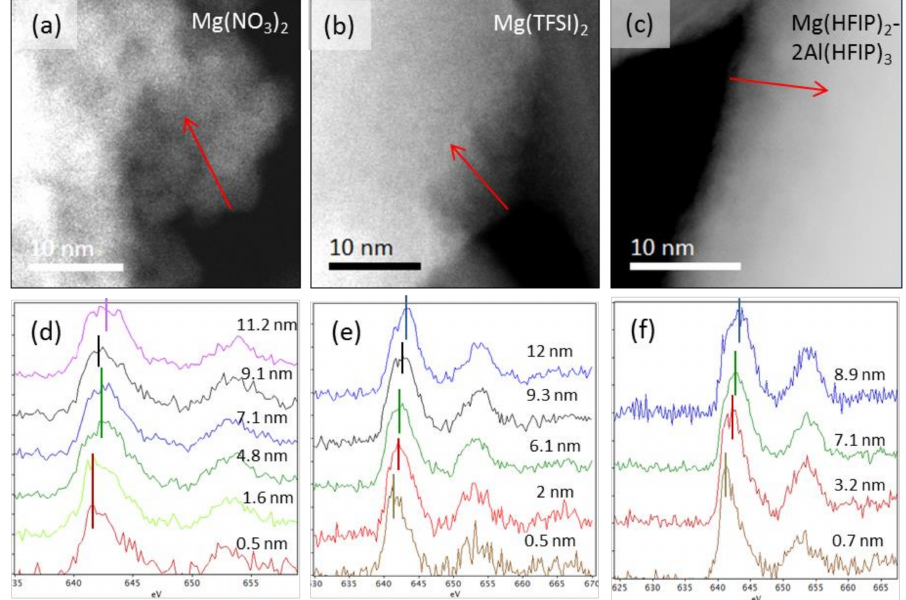
Figure 7. STEM-HAADF images with marked position and direction of EELS line scans for cathode material samples cycled in ( a ) Mg(NO 3 ) 2 , ( b ) Mg(TFSI) 2 , and ( c ) Mg(HFIP) 2 − 2Al(HFIP) 3 electrolytes. In ( d , e , f ), the corresponding plots of Mn L 2,3 edge vs. distance from the particle’s surface into the interior are